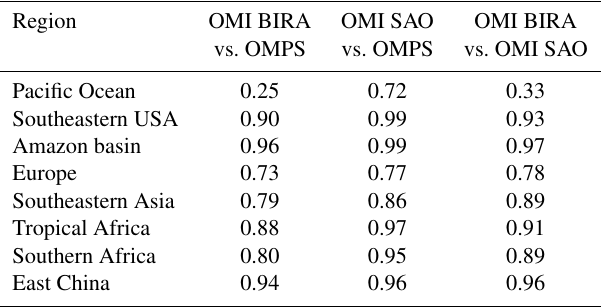
Table 4. Linear Pearson coefficient of the temporal correlation be- tween monthly mean time series shown in Fig.